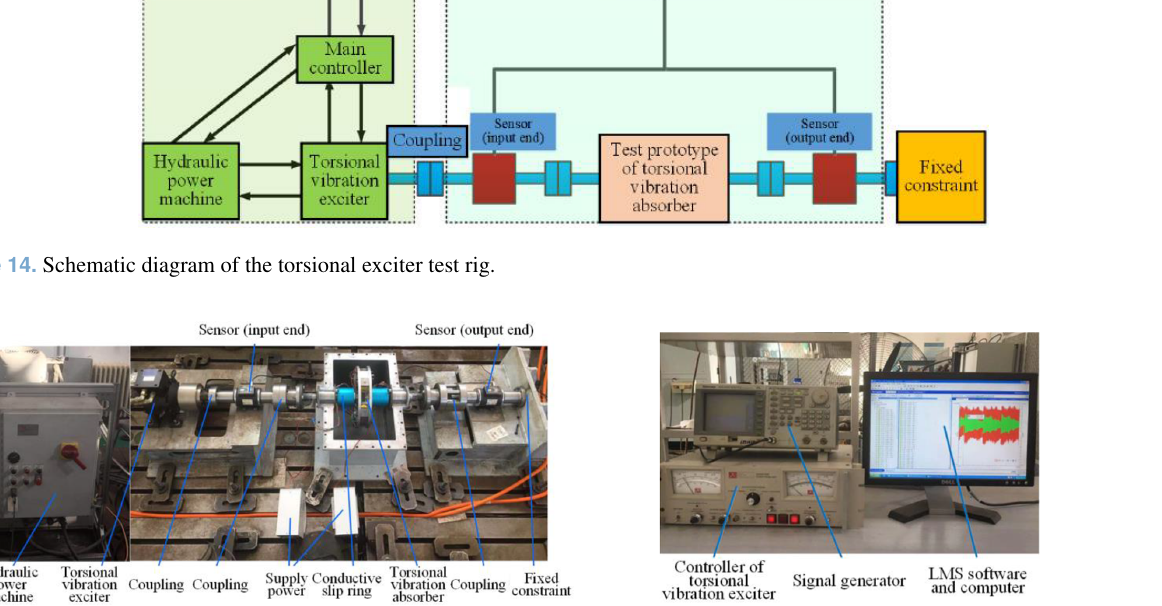
Figure 15. Real layouts of the test rig.